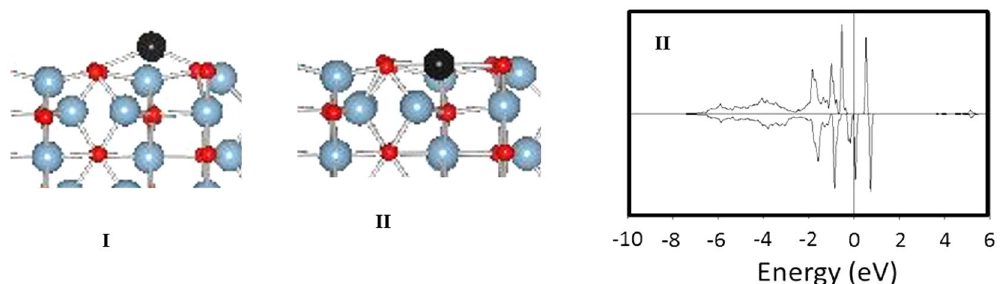
Figure 5. (I) Pd adatom 42 and (II) Pd cation on θ -alumina (010) surface and its PDOS of